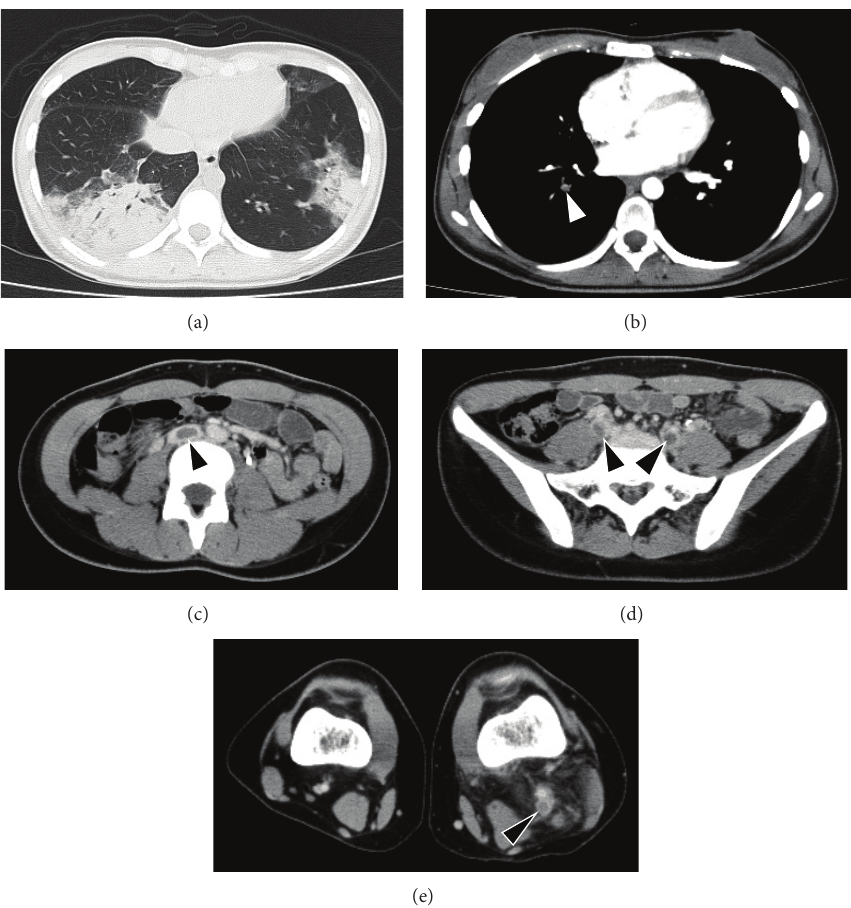
Figure 1: Computed tomographic scan showing consolidations in bilateral lower lungs (a), pulmonary embolism in the right pulmonary artery ((b), white arrowhead), and extensive DVT throughout inferior vena cava to left posterior tibial vein ((c)–(e), black arrowheads).